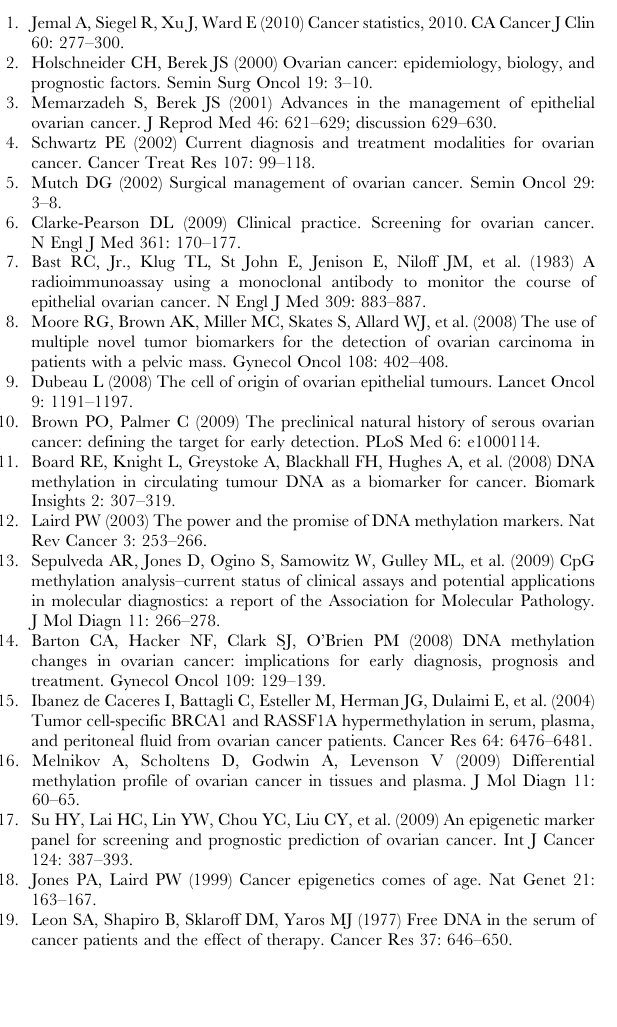
Table S4 CA-125 and IFFO1-M levels in the serially collected serum samples of nine patients with ovarian